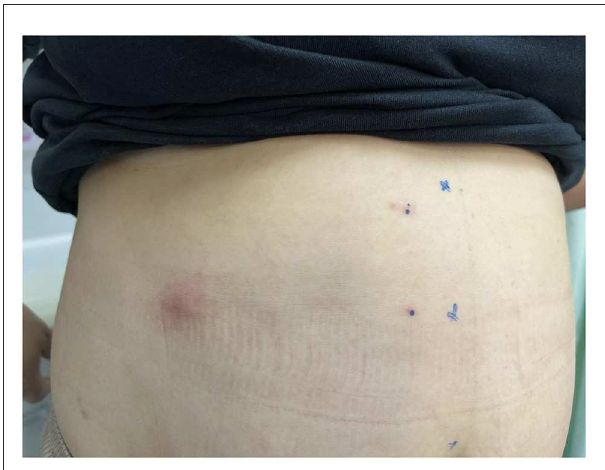
FIGURE1 Abdominal illustration of ZRN patient for locating the target nerve based on the location of new rashes.